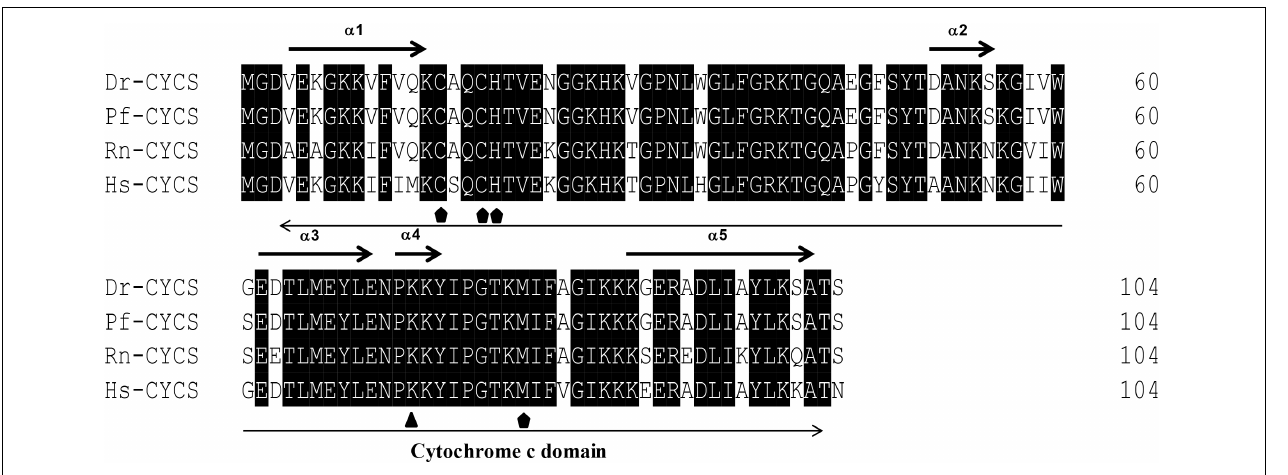
FIGURE 1 | Multiple amino acid sequence alignments of Cycs genes of Pelteobagrus fulvidraco and other species. Accession numbers are ENSRNOP00000041521, NM_018947.5, NM_001002068.1, KY053836 for Rattus norvegicus (Rn), Homo sapiens (Hs), Danio rerio (Dr), and Pelteobagrus fulvidraco (Pf), respectively. Arrows above and below the sequences represent α -helices and the Cytochrome c domain, respectively. Residues below symbols ( ) were identified as a specific site, including the interactive sites with heme and iron ion. Residues below symbol ( ) means the modified sites of trimethyllysine.